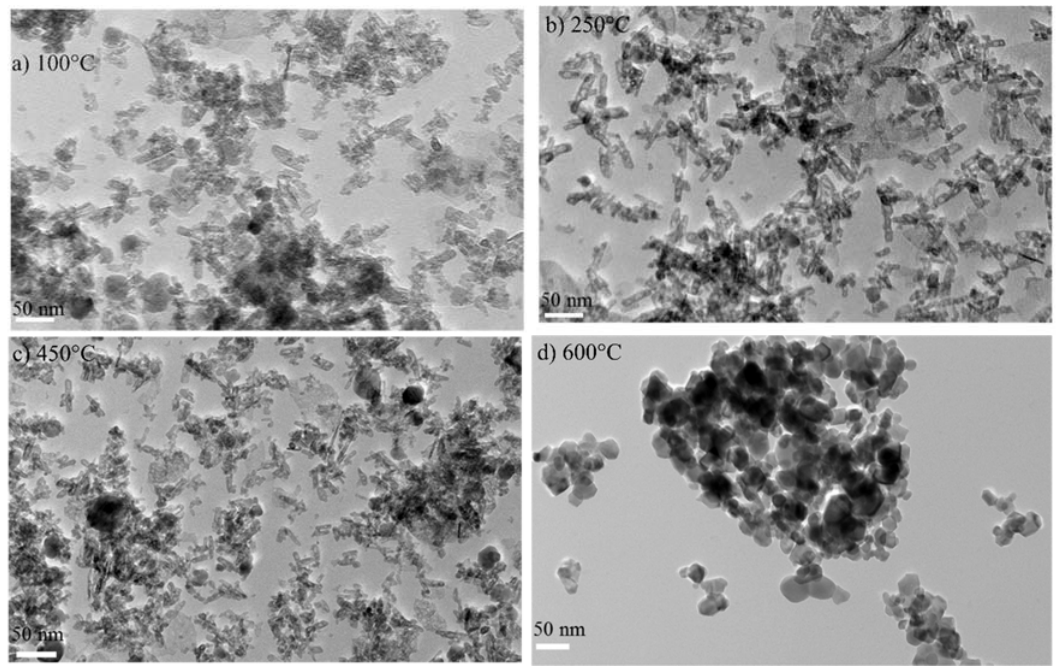
Figure 2. TEM of Ni Fe oxide at different temperatures ( a ) 100 °C; ( b ) 250 °C; ( c ) 450 °C and ( d ) 600 °C. Table 1. N 2 isotherm characteristics of the Ni Fe oxide at different temperatures.